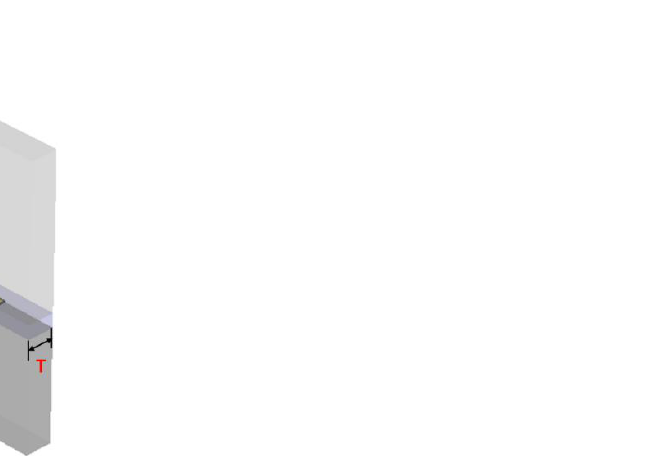
6 of 12 Figure 5. The S − parameter comparisons between the modeled system in ADS with measurement results for ( a ) the whole frequency range of 4 − 18 GHz, tuned at 11 GHz, in the frequency step of 5 MHz; and ( b ) the frequency range of 12 − 14 GHz, tuned at 13 GHz, in the frequency step of 50 kHz. For the sensor simulation, a small sensing CPW section of the length T equals 10 µm has been modeled in CST (Figure 6). To obtain fast and accurate simulation results of the particle passing through the sensing CPW, the cubic particle with a side length R = 3 µm is used in the model. The simulations are carried out for the particle at different positions relative to the cross-section of the sensing CPW at a center height of 2.5 µm above the substrate. The simulation results depicted in Figure 7 are the magnitude and the phase of transmission signal S 21 . The blue solid line and the orange ribbons around it are simulation results and their error range, respectively. While the yellow solid line and blue ribbon around it are respectively the mirrored simulation results and their error range of the left half to demonstrate their symmetry with the right half of the simulation results. The par- ticle introduces signal variations when it passes through the region with high electromag- netic (EM) fields. As well, in correspondence with the EM field intensity, which is highest at the two gaps and relatively low at the center of the signal line, the variation signal caused by the particle shows a profile of “M” shape for both the magnitude and phase of S 21 . To have a particle signal profile of the modeled system response, the simulation re- sults of the sensor in CST are combined with the system modeling in ADS, as given in Figure 4b. The TL_CST unit is introduced in both the two branches for a better match of the signals and highlights the signal variation caused by the particle. The TL_CST_GND unit in the REF branch is loaded with simulation results of the particle above the ground